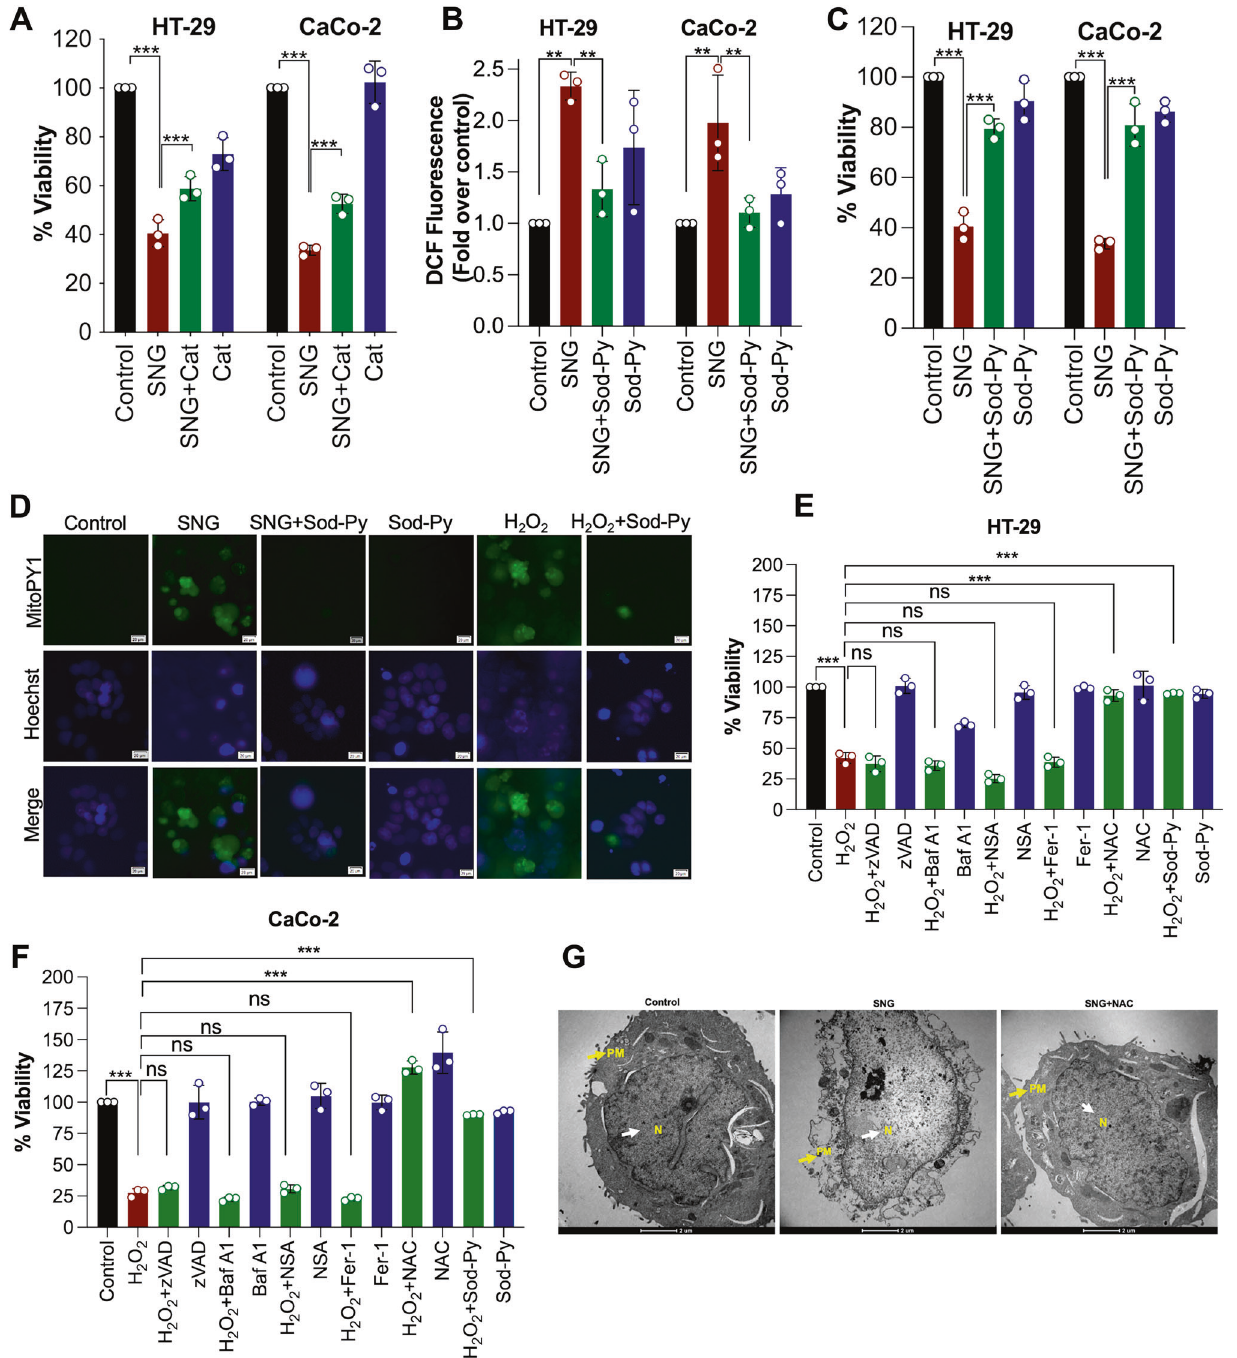
Fig. 4 SNG-induced cell death is associated with the features of oxeiptosis. A CRC cells were treated with SNG in the presence or absence of Cat. Cell viability was assessed by MTT assay. Data shown are means ± SD ( n = 3) (*** p < 0.001). CRC cells were treated with SNG in the presence or absence of Sod-Py. B ROS assay was performed by using DCFH-DA and C Cell viability using MTT assay was carried out. Data shown are means ± SD ( n = 3) (** p < 0.01 and *** p < 0.001) D HT-29 cells were treated with 10 µM MitoPY1 for 1 h at 37 °C. The medium was replaced with fresh growth media containing Hoechst 33342 dye (1.5 µl; 10 mg/ml stock solution). Following the treatment with SNG in the presence or absence of Sod-Py for 30 min, the fl uorescence of Hoechst (blue), and MitoPY1 (green) was captured by fl uorescent microscopy. H 2 O 2 (1 mM) was used as a positive control. Scale bar: 20 µm. E HT-29 and F CaCo-2 cells were treated with H 2 O 2 (500 µM) in the presence or absence of indicated inhibitors. Following the treatment, cell viability was performed by MTT assay. Data shown are means ± SD ( n = 3) (*** p < 0.001, ns = no signi fi cance). G Representative TEM images of HT-29 cells treated with SNG in the presence or absence of NAC for 16 h. The yellow arrowheads indicate plasma membrane and the white arrowhead indicates nucleus (PM, plasma membrane; N, nucleus). Scale bar: 2